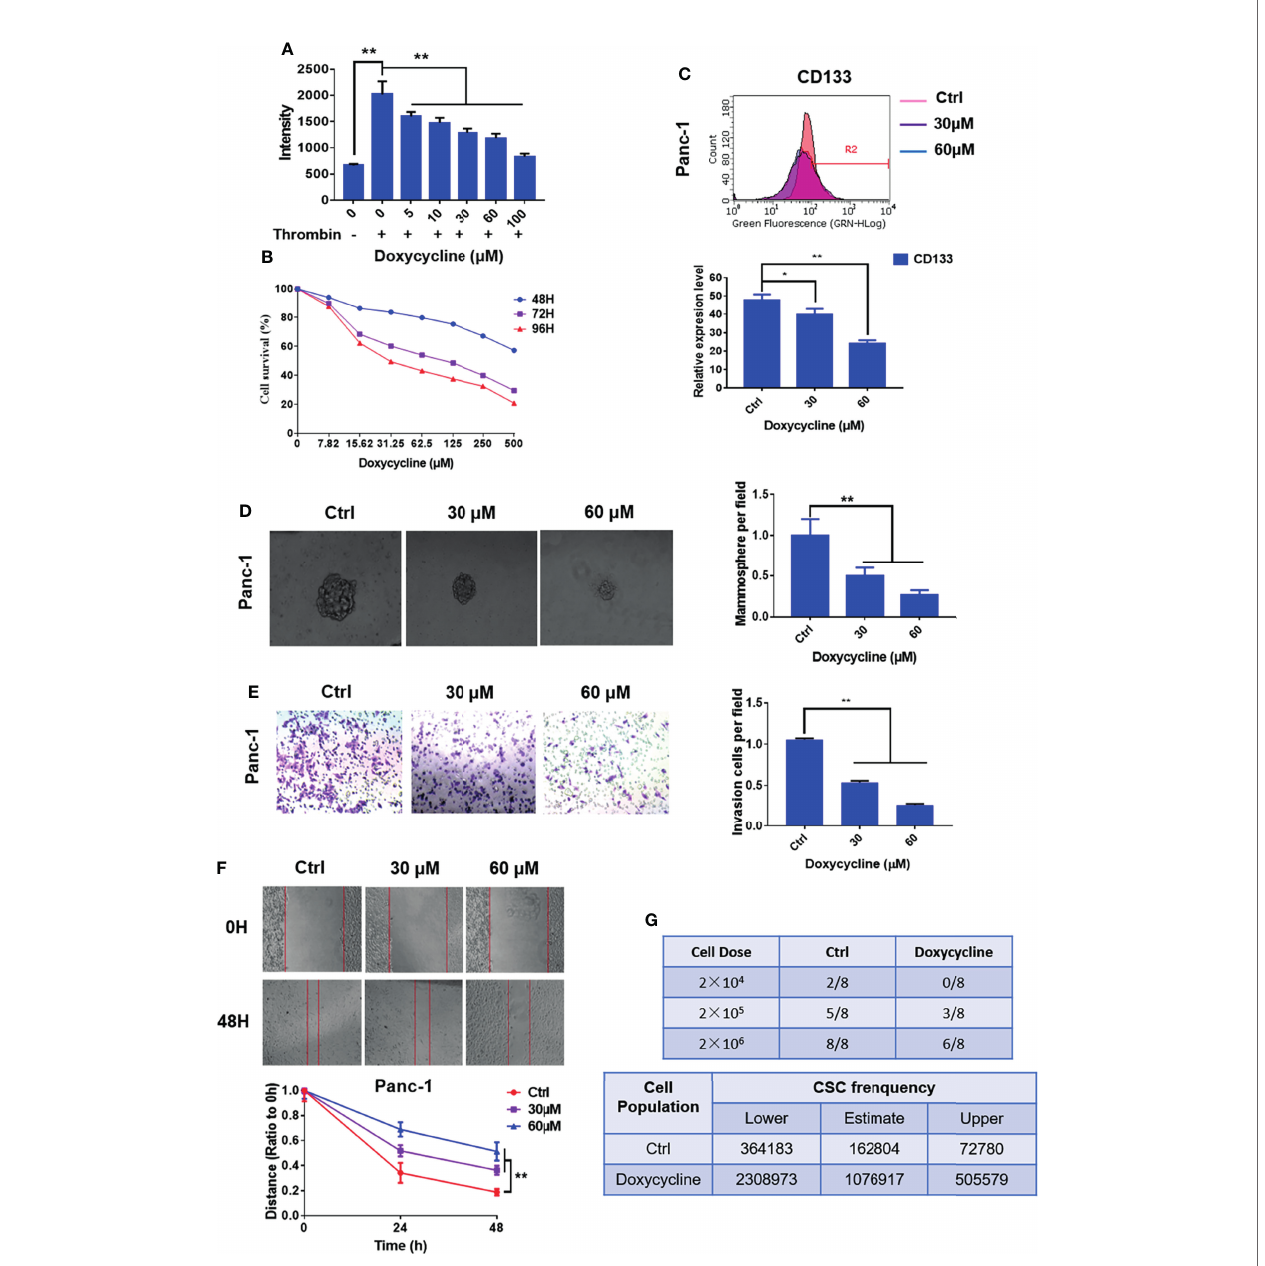
FIGURE 5 | Doxycycline inhibits the cancer stem cell-like properties of pancreatic cancer cells. (A) Effect of doxycycline on PAR1 activation stimulated by thrombin in pancreatic cancer cells detected by the Ca 2+ -mobilization assay. (B) Effect of doxycycline on pancreatic cancer cell viability after 48, 72, and 96 h treatment. (C) Effect of doxycycline on pancreatic cancer stem cell marker CD133 in Panc-1 cells. (D) Effect of doxycycline on the mammosphere formation of Panc-1 cells. (E) Effect of doxycycline on pancreatic cancer cell invasion ability. (F) Effect of doxycycline on pancreatic cancer cells migration ability. (G) Limiting dilution assay of pancreatic cancer stem cell from Panc-1 cells after treatment with doxycycline in node mice ( n = 8). Cancer stem cell frequency was determined by ELDA. Data are shown as the mean ± SD (* P < 0.05, ** P <